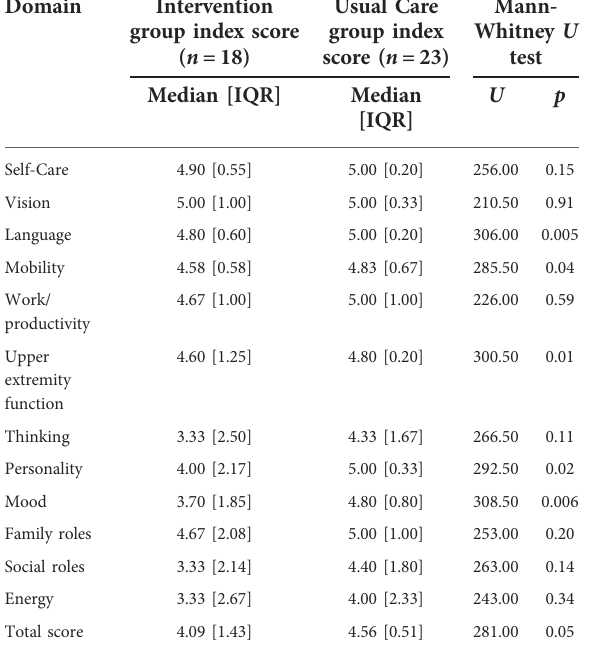
TABLE 6 SSQOL index